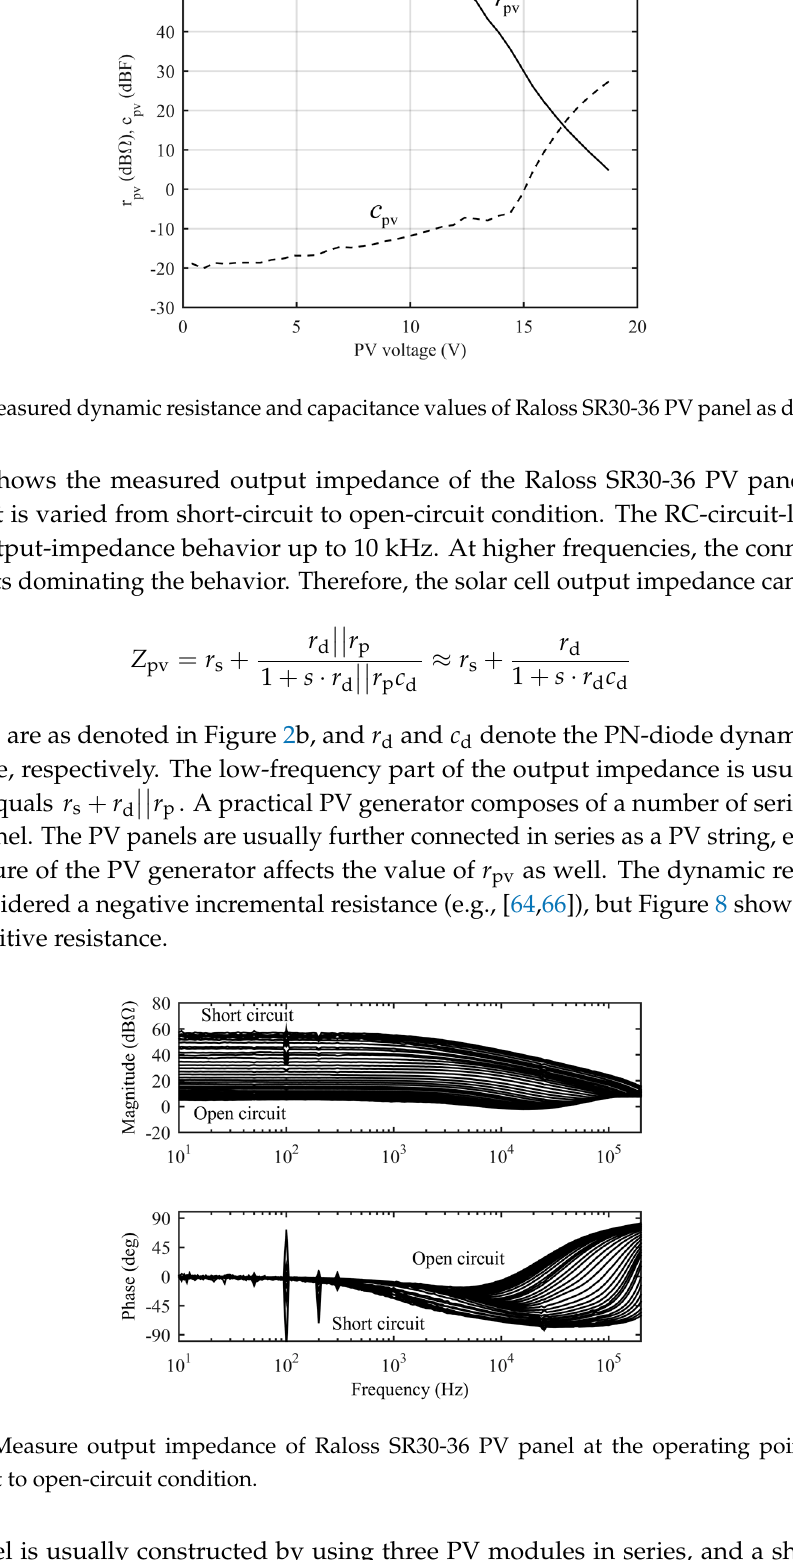
Energies 2017 , 10 , 1076 6 of 26 Figure 6. Authentic behavior of dynamic and static resistances of Raloss SR30-36 PV panel ( top ); and their extended view ( bottom ).